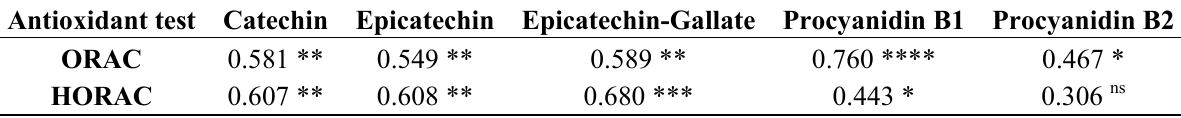
Table 3. Correlations between ORAC and HORAC antioxidant activities and different flavanols and proanthocyanidins in SDI, RDI and NI seeds during 2007 and 2008 seasons. Antioxidant